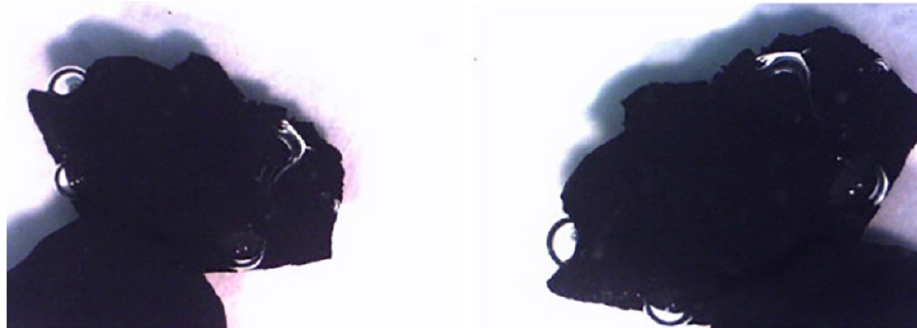
Figure 8. No. 6 CR trapped air bubbles in water [76].